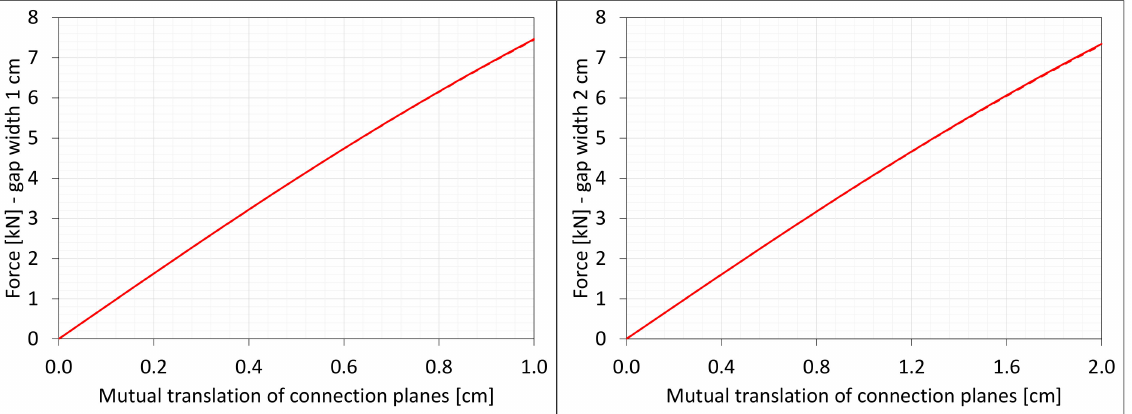
Figure 29. Equilibrium paths for shear force V y . The width of the gap is equal to 1.0 cm, left graphic, and 2.0 cm, right graphic. Plane strain models, solid lines; and 3D models, dashed lines (curves from Figure